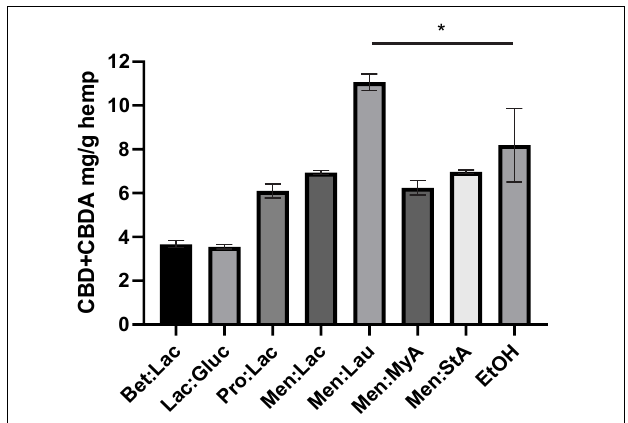
FIGURE 1 | Extraction of CBD + CBDA from the hemp using different DESs. The extraction conditions were as follows: 60 ◦ C, 90 min, and a 1:10 solid-liquid ratio (w/w). The symbol * means that there are statistical differences between Men:Lau and EtOH.